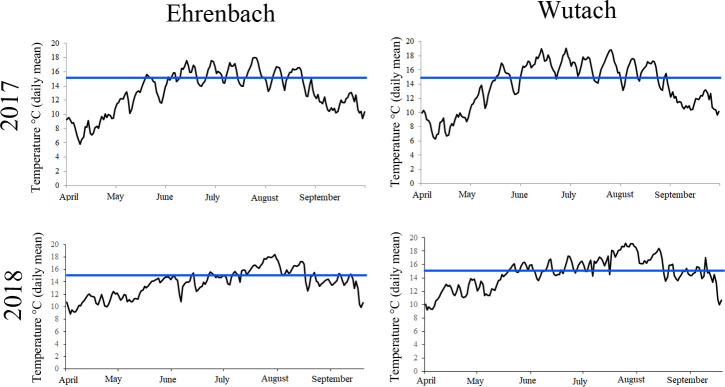
Temperature profiles from the rivers Ehrenbach and Wutach, 2017 and 2018.PKD is temperature dependent with the disease getting clinically relevant at water temperature above 15°C. The blue line in the temperature profiles marks the 15°C line.